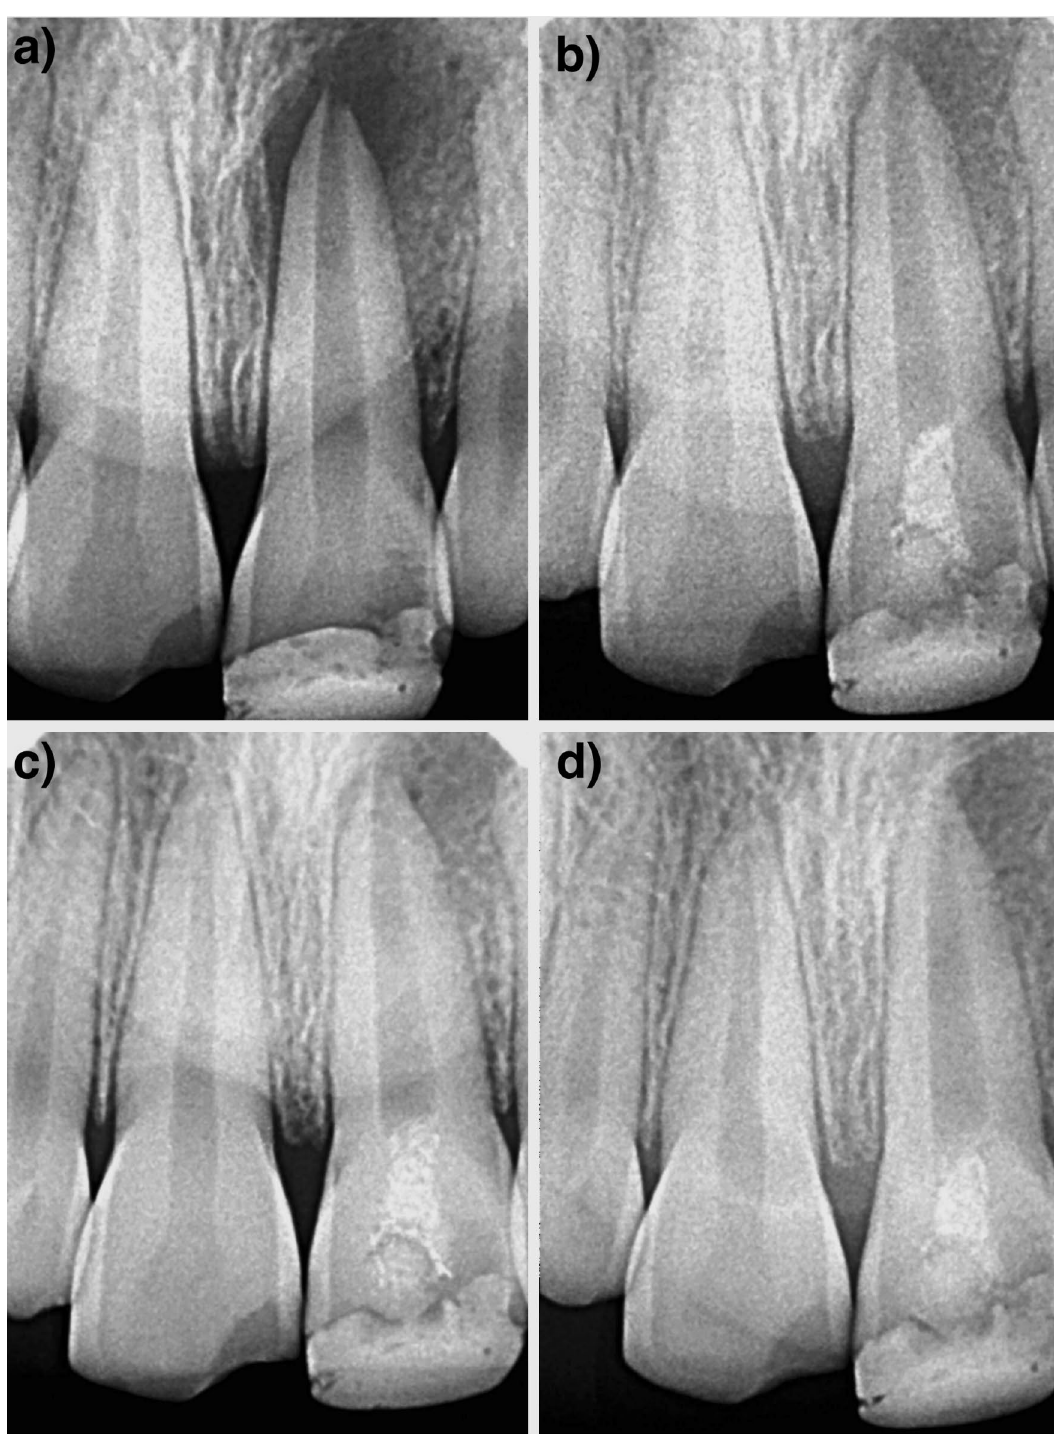
Figure 3. Case 2: Tooth no. 21- ( A ) Preoperative radiograph; ( B – D ) Radiographs at 6 months, 12 months and 24 months follow-up